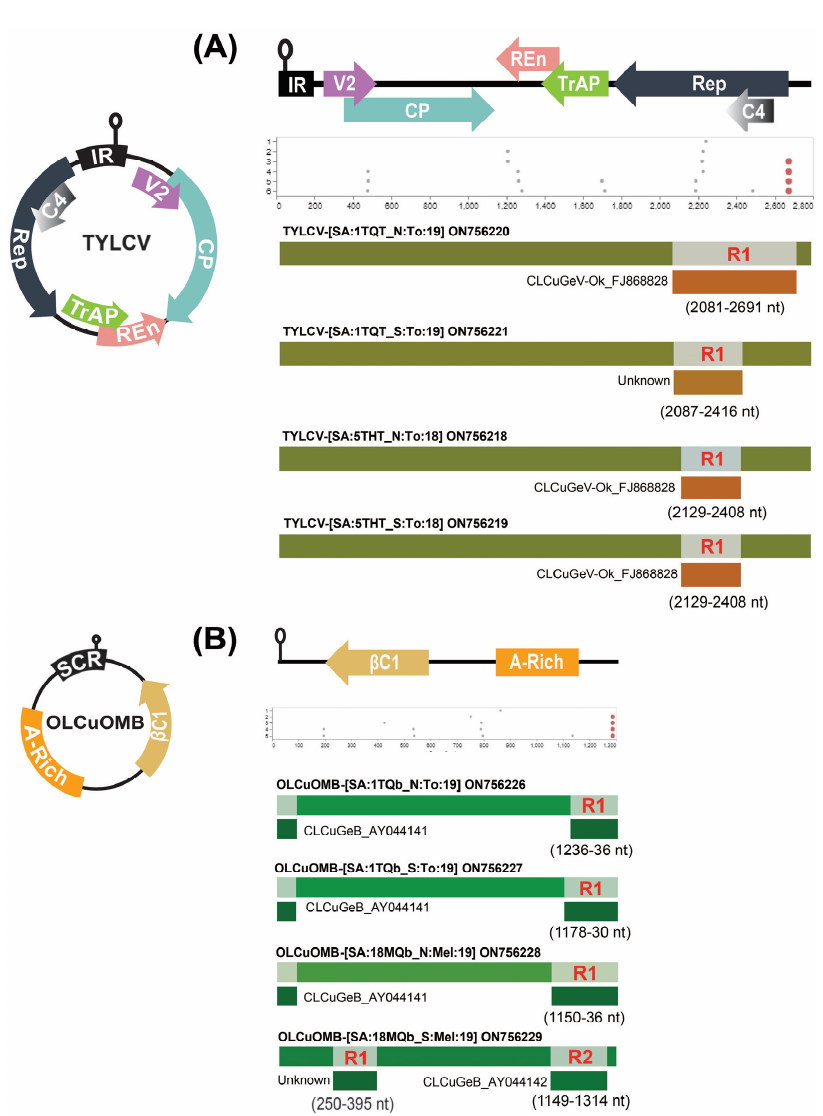
Figure 4. Detection of recombination events using Recombination Detection Program (RDP5.0). ( A ) Recombination analysis of the potential recombinant begomovirus and ( B ) betasatellite isolates. The graphical representation of begomovirus and betasatellite genomes is followed by GARD and RDP analyses, respectively.